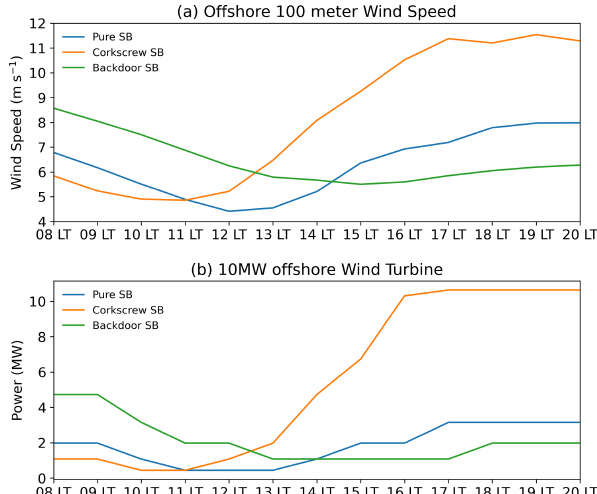
Figure 12. Time series of (a) offshore hub-height wind speed (ms − 1 ) and (b) the associated power output from a 10MW wind turbine with respect to sea breeze type between 08:00 and